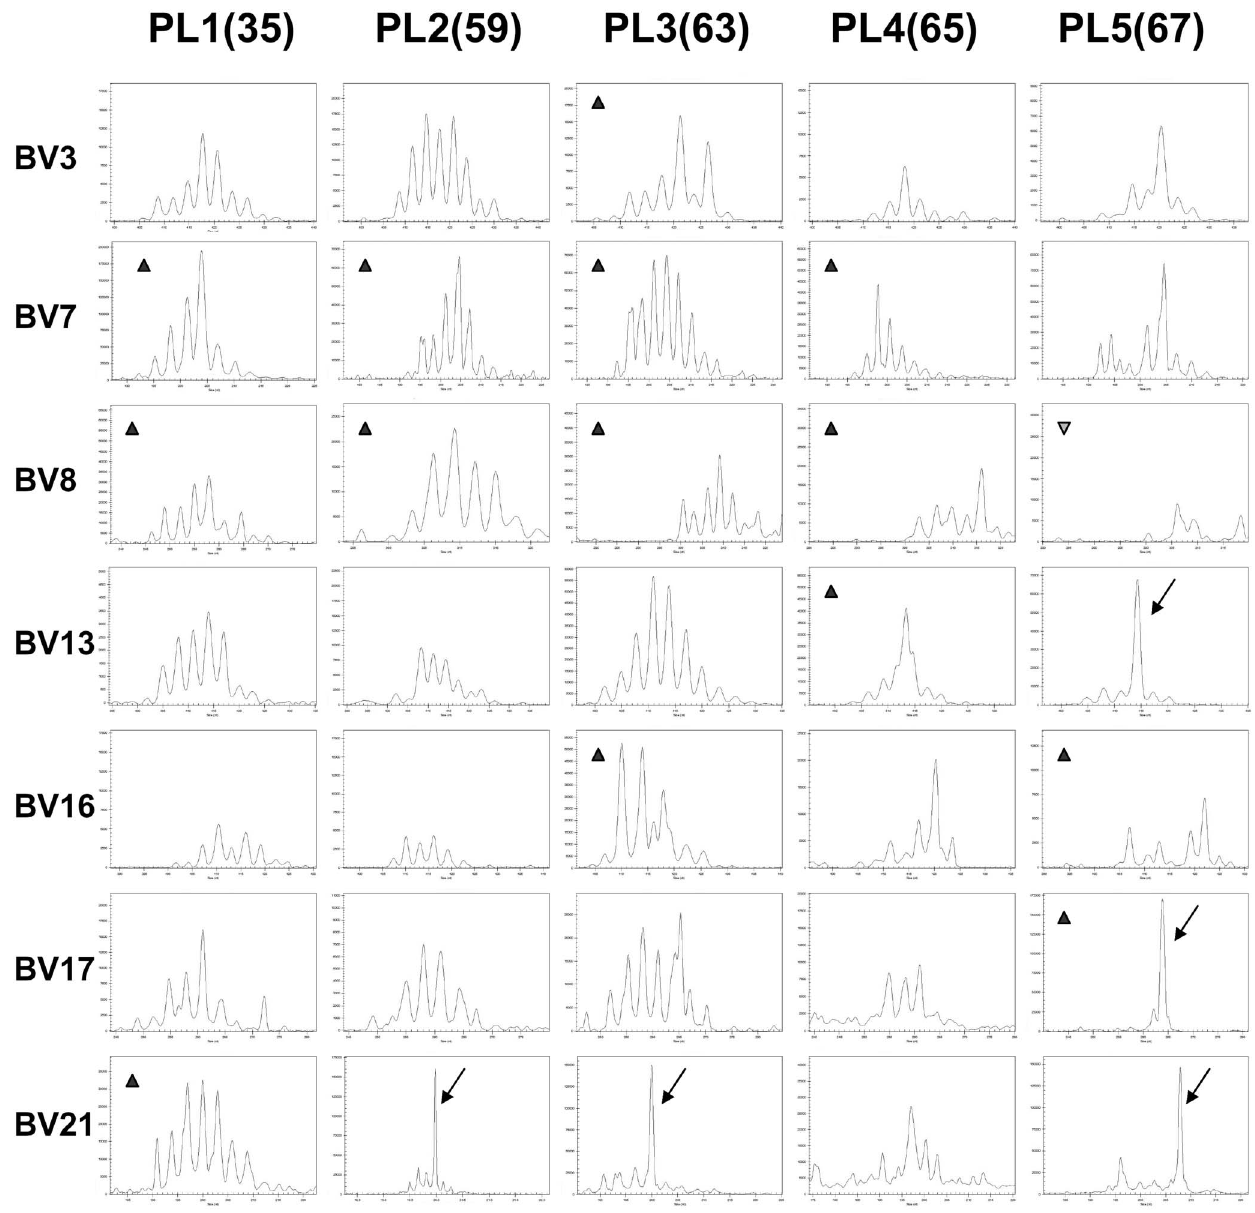
Figure 4. Analysis of clonal expansion in TIL of 5 lung cancer patients. Seven TCR subfamilies (BV3, BV7, BV8, BV13, BV16, BV17, and BV21) overexpressed in TIL of five lung cancer patients were selected to show the CDR length distribution. Decreased numbers and/or biased distribution of CDR3 peaks with increased age of patients were shown. TCRBV21, which did not display remarkable overexpression by FCM detection, but showed oligoclonal/monoclonal expansion pattern in 3 out of 5 TIL specimens, was selected as the control. The numbers in brackets are the ages of patients. The arrows point to monoclonal expansion peaks. The triangle ( m ) means overexpression, and inverted-triangle ( . ) means underexpression, as shown in Figure